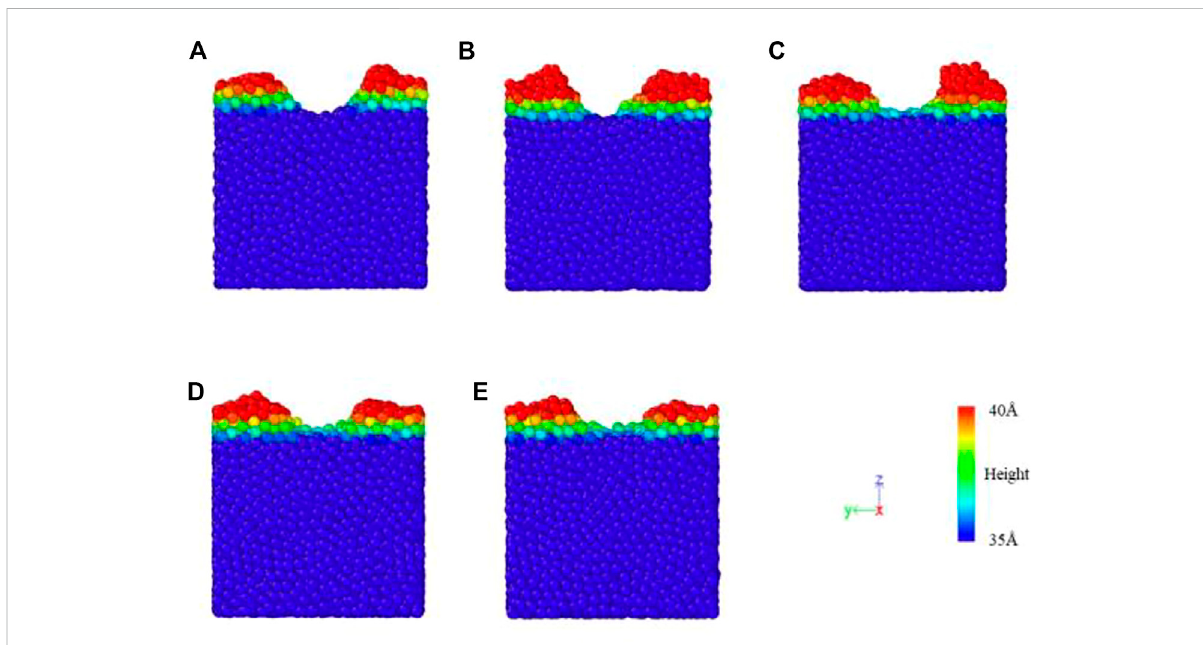
FIGURE 3 ThescratchdepthofdifferentAl 2 O 3 contentin400ps: (A) pureFe-basedamorphousmodel; (B) 5 wt%Al 2 O 3 /Feamorphouscompositemodel; (C) 10 wt% Al 2 O 3 /Fe amorphous composite model; (D) 10 wt% Al 2 O 3 /Fe amorphous composite model; (E) 20 wt% Al 2 O 3 /Fe amorphous composite model.